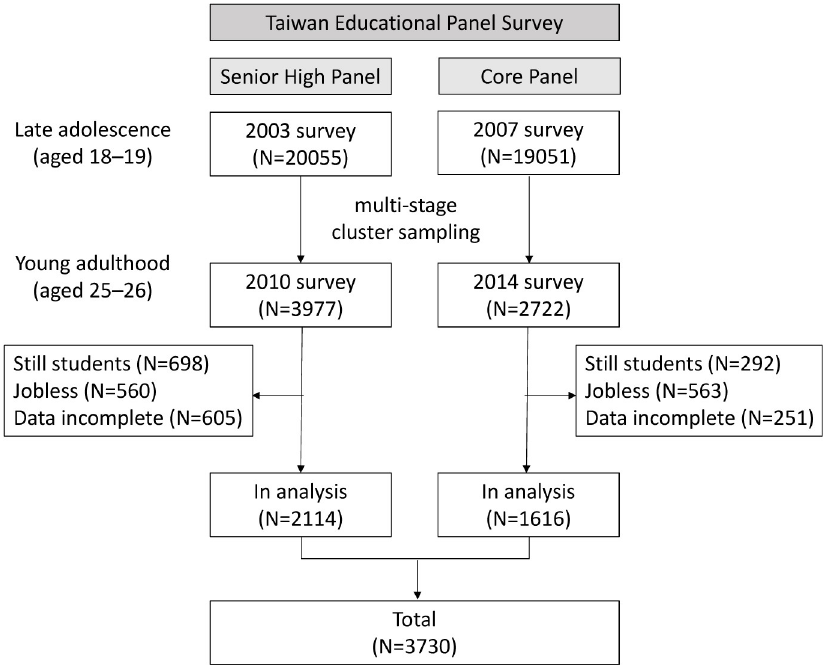
Fig 1. Flowchart of sample